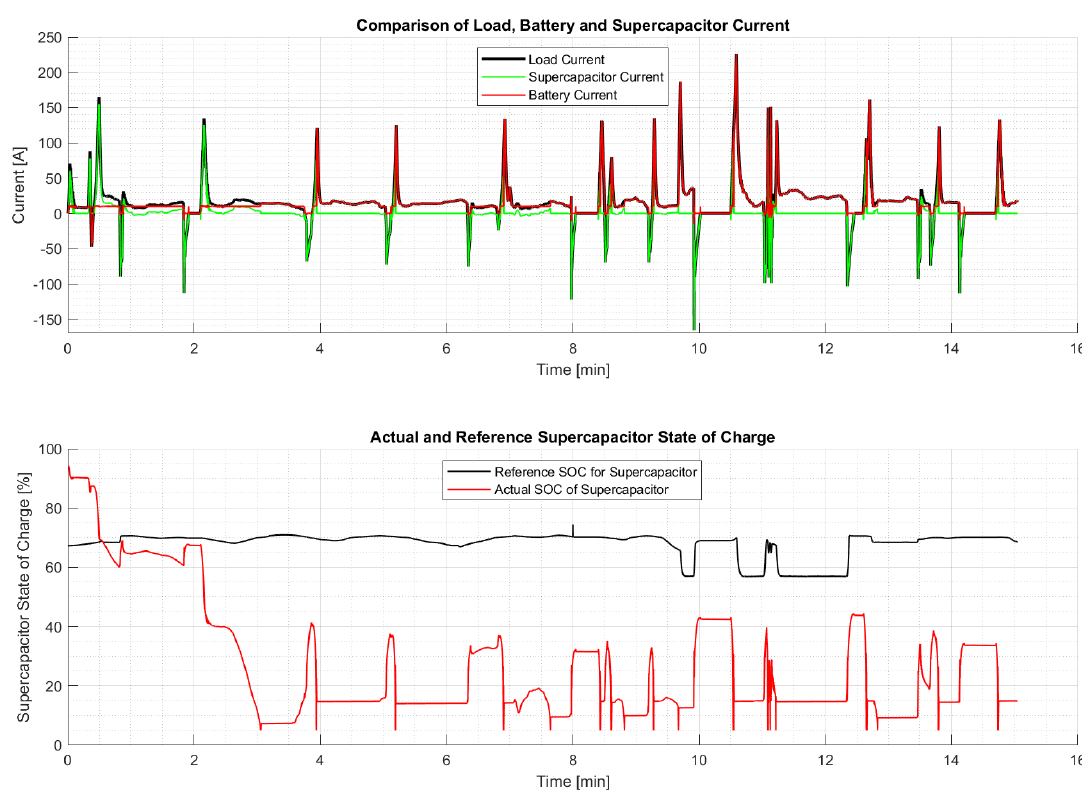
Figure 7. Current distribution and supercapacitor state of charge (actual/reference value) for simu- lated journey on